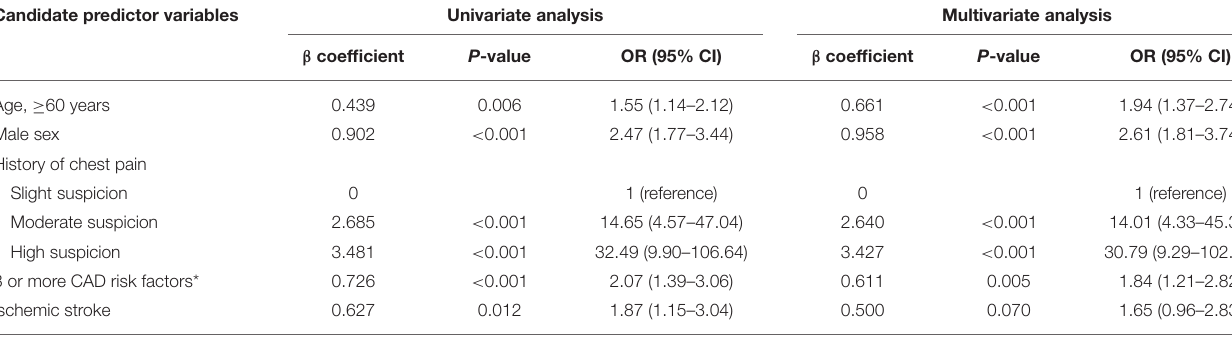
TABLE 2 | Candidate predictor variables of the score in univariate and multivariate logistic regression analysis. Candidate predictor variables